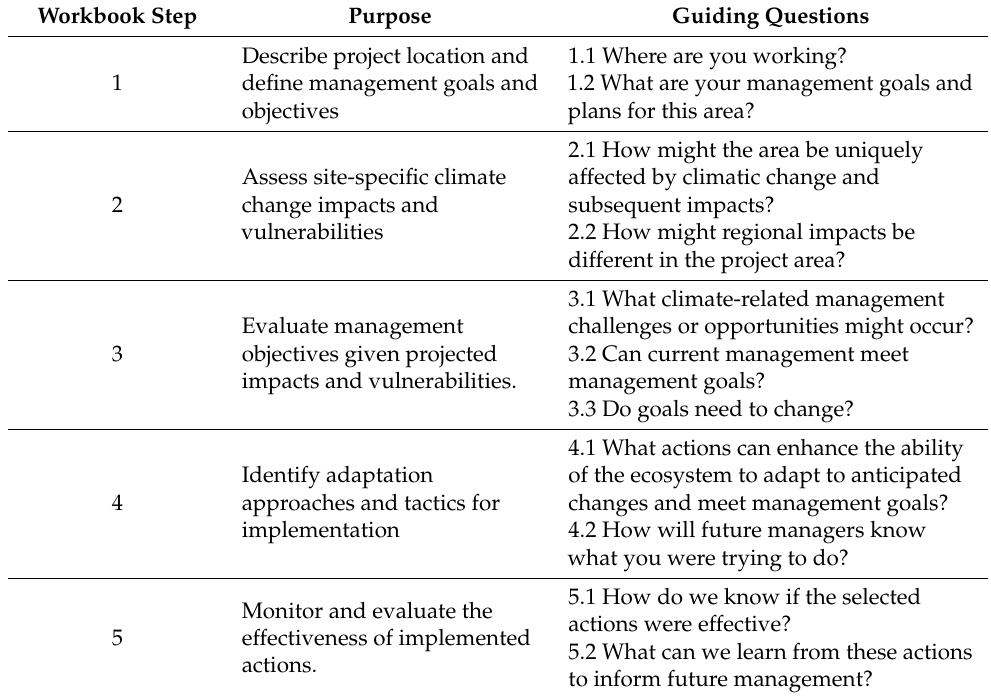
Table 1. Key concepts for leading project teams through the steps of the Adaptation Workbook during an APP. See S2 for more information on process and group